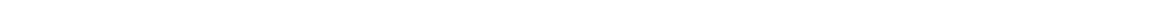
Fig. 6 NLRP11 promotes K48-linked poly-ubiquitination of TRAF6. a 293T cells transfected with the indicated plasmids were subjected to immunoprecipitation and then immunoblotted with the indicated antibodies. b A schematic diagram of TRAF6 and its mutants. c , d 293T cells were transfected with Myc-NLRP11, HA-K48-Ub, and Flag-TRAF6 RK c or KR d mutants with the indicated combinations for 24 h and then treated with MG132 (10 μ M) for 6 h. WCLs were subjected to denaturing immunoprecipitation with anti-Flag beads and then analyzed by immunoblotting with an anti-HA or anti-Flag antibody. e TRAF6 KO 293T cells transfected with TRAF6 WT or 3KR mutant and Myc-NLRP11 were subjected to denaturing immunoprecipitation with an anti-Flag antibody followed by immunoblotting with the indicated antibodies. All the cells were treated with 10 μ M MG132 for 6 h before collecting. f Immunoblot analysis of 293T cells transfected with the indicated combinations of expression plasmids g TRAF6 KO 293T cells were transfected with the indicated plasmids together with the NF- κ B luciferase reporter and pTK- Renilla reporter plasmids for 24 h before luciferase assays were performed. Data a and c – f are representatives of three independent experiments with similar results. Data g are shown as mean ± SEM of combined from three independent experiments with triplicate. *** P < 0.001 compared to the control group (Student ’ s t-